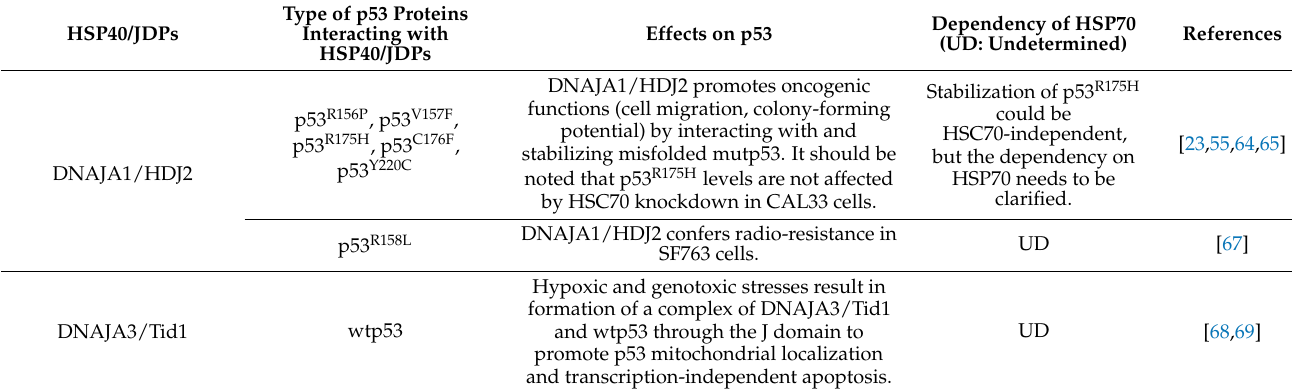
Table 1. Functional interactions between HSP40/JDPs and